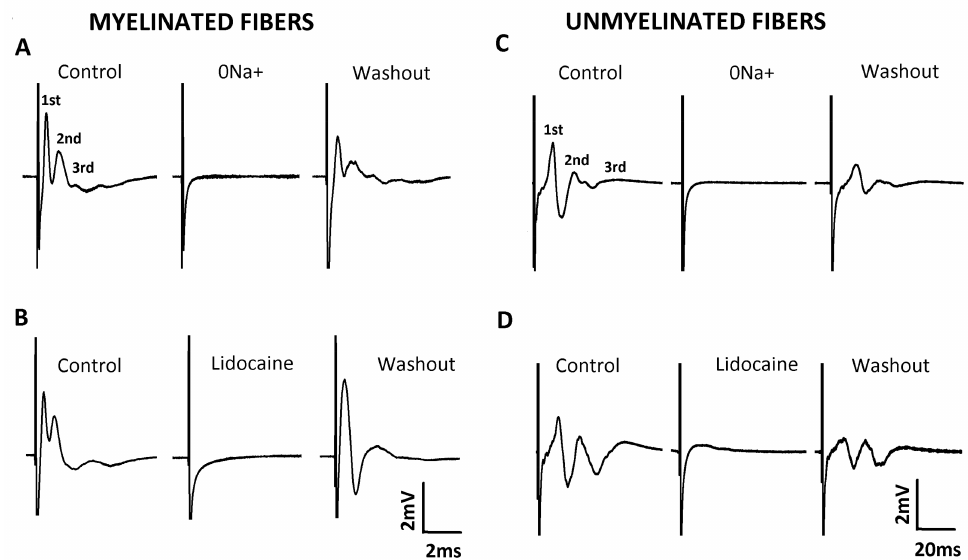
Figure 2. Characterization of extracellular recording of the compound action potential (CAP). Rep- resentative traces of the CAP of myelinated ( A , B ) and unmyelinated fibers ( C , D ). The upper traces illustrate the effect of removing Na + from the extracellular solution, while the lower traces illustrate the effect of lidocaine (1 mM) on the CAP of vagal fibers. The 1st, 2nd, and 3rd indicate the CAP components for both registers.